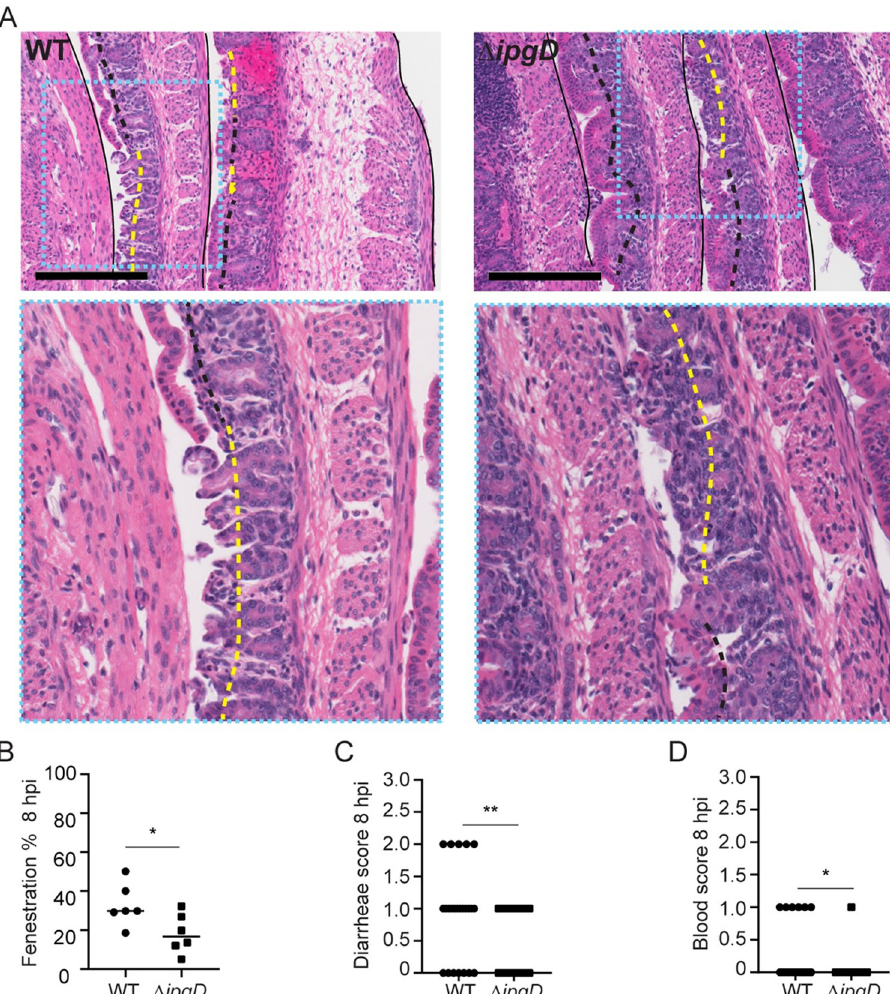
Fig 7. Role of IpgD in pathogenesis. (A) Representative images of hematoxylin- and eosin-stained colonic sections from animals infected with the S . flexneri pCFP (WT and Δ ipgD ) 8 hpi. Intact black lines, colonic tissues; dashed black lines, intact epithelium; yellow dashed lines, fenestrated epithelium; scale bar, 200 μ m; inset, turquoise dashed rectangle, magnified colon regions to illustrate intact and fenestrated epithelium. (B) Graph showing quantification of colon fenestration at 8 hpi ( n = 6 per strain). (C) Graph showing diarrhea scores of 24 animals per strain 8 hpi. (D) Graph showing blood scores of 24 animals per strain 8 hpi. Statistics (Panels B-D): unpaired t-test; � P < 0.05, �� P < 0.01.